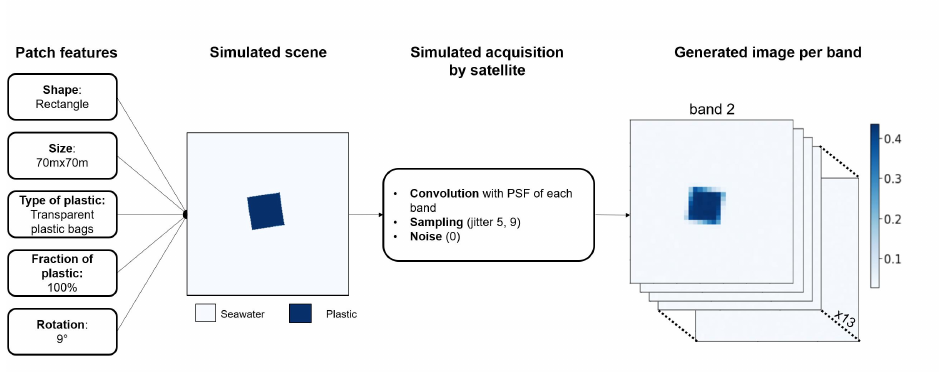
Figure 4. Illustration of the inputs and outputs of the